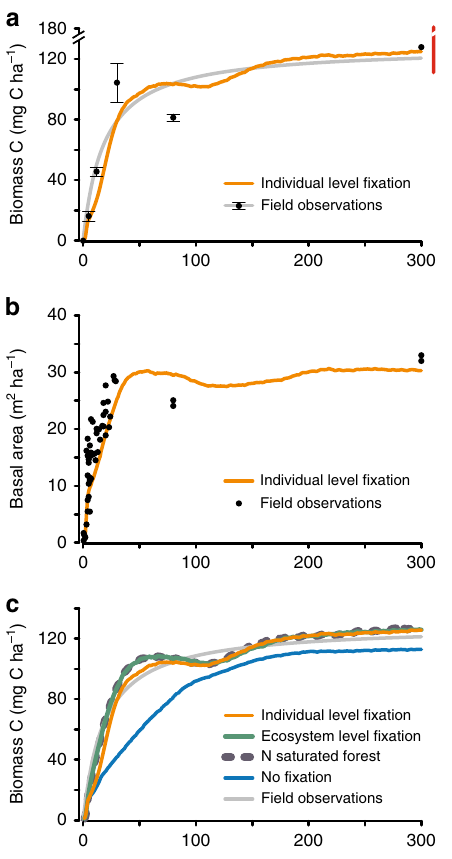
Fig. 2 Nitrogen cycle in tropical rainforests recovering from land use. (years) observed in Panama 6 (black points represent mean ± SEM for n = 4 plots per year for forests 5 – 30 years and n = 2 plots per year for forests 80 – 300 years) and predicted by our model for forests that include all plant functional types and nitrogen fi xation regulated at the individual plant level (individual level fi xation; orange line) or fi xation scaled to an ecosystem property, such as forest evapotranspiration (ecosystem level fi xation; green (years) predicted by our model for forests with individual (orange line) or ecosystem-level fi xation (green line), as described in ( a ). c The increase in soil nitrogen (N; %) predicted by our model for forests that include all plant functional types and individual level fi xation compared to forests without fi xation. The increase in soil nitrogen was calculated from model predictions of forests with all plant function types and fi xation minus forests with all plant functional types and no fi xation. For all model scenarios, the pattern of variation in nitrogen fl uxes re fl ect our use of a looped 16-year meteorological dataset from ASP